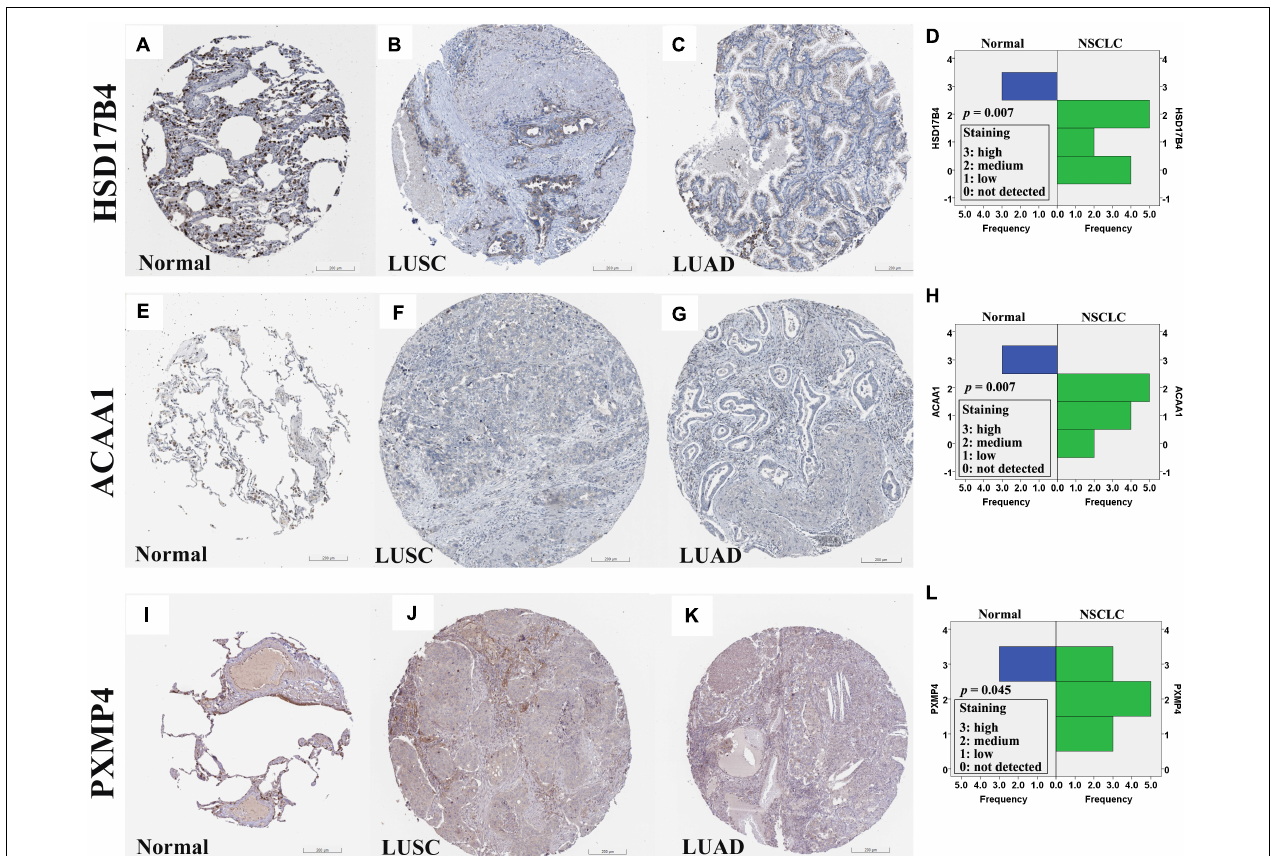
FIGURE 5 | Immunohistochemical staining for HSD17B4, ACAA1, and PXMP4 in normal lung tissues and NSCLC tumors. (A–C) HSD17B4 staining in normal lung (high in pneumocytes), LUSC (low in tumor cells), and LUAD (low in tumor cells), respectively. (E–G) ACAA1 staining in normal lung (medium in pneumocytes), LUSC (low in tumor cells), and LUAD (low in tumor cells), respectively. (I–K) PXMP4 staining in normal lung (high in pneumocytes), LUSC (low in tumor cells), and LUAD (low in tumor cells), respectively. Through Wilcoxon test, HSD17B4 (D) , ACAA1 (H) and PXMP4 (L) was shown to be lower expressed in the NSCLC tumor cells than the normal lung pneumocytes, respectively. NSCLC, non-small cell lung cancer; LUSC, lung squamous carcinoma; LUAD, lung adenocarcinoma. All the immunostaining pictures were downloaded from HPA database. Antibody HPA021302 (A–C) , HPA007244 (E–G) , and CAB002427 (I–K) were used for